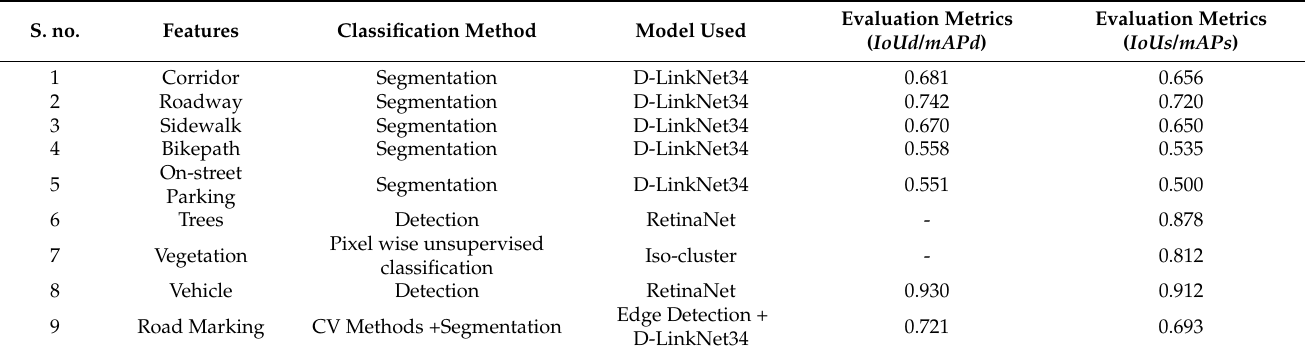
Table 3. Summary of training details of the streetscape features.